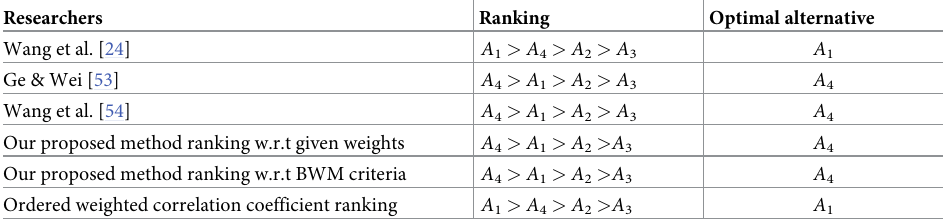
Table 7. Comparison of obtained